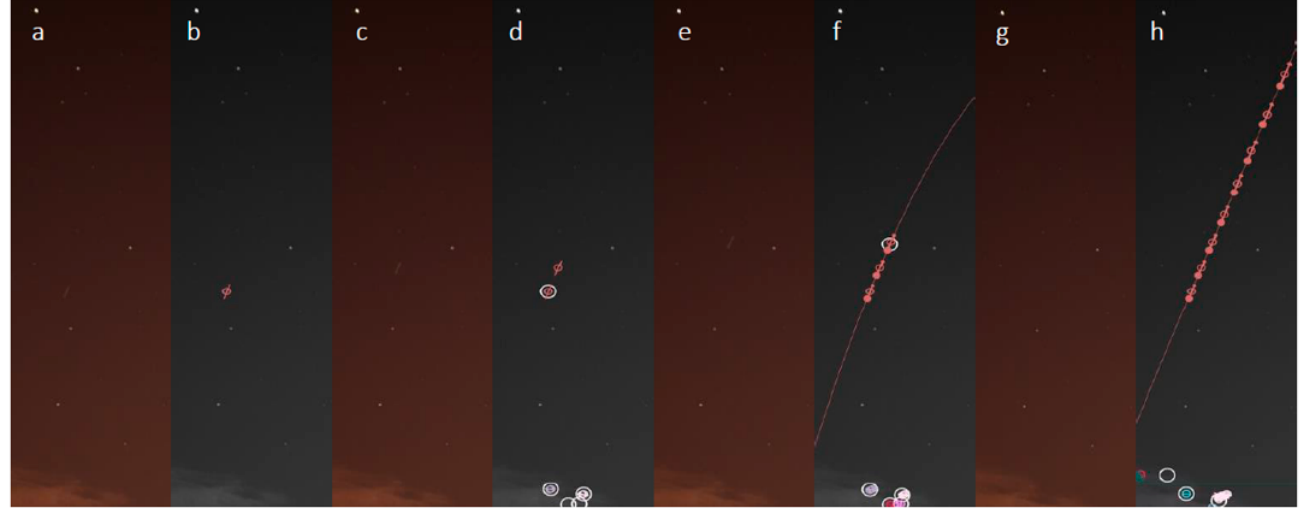
Figure 14. The evolution of a tracklet: ( a , b ) a new streak is detected, and a tracklet is formed; ( c , d ) the tracklet, in state 1, will be associated with a newly detected streak, and its state will be changed to 2; ( e , f ) the tracklet is in state 2 and associates with a new streak that matches the prediction of speed and orientation; ( g , h ) a completed tracklet, in state 3.